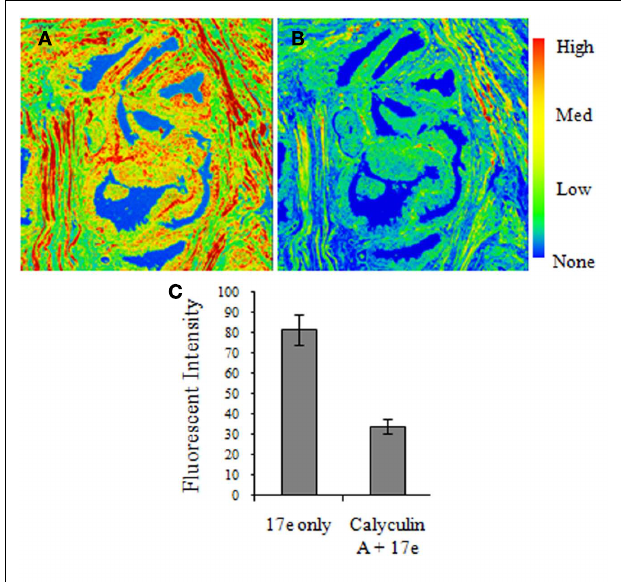
FIGURE 8 | CalyculinA treatment causes a reduction in 17e binding to human prostate cancer tissue. Serial sections of human prostate tissue were stained with (A) 17e (10 μ M) for 1h and (B) pretreated with calyculin A (1 μ M) for 10min followed by 17e (10 μ M) for 1h. Random regions of the tissue from each section were imaged for the average fluorescence intensity of 17e (C) showing that calyculin A causes a 60% reduction in 17e binding ( p < 0.0005). Error is represented by SEM, n =